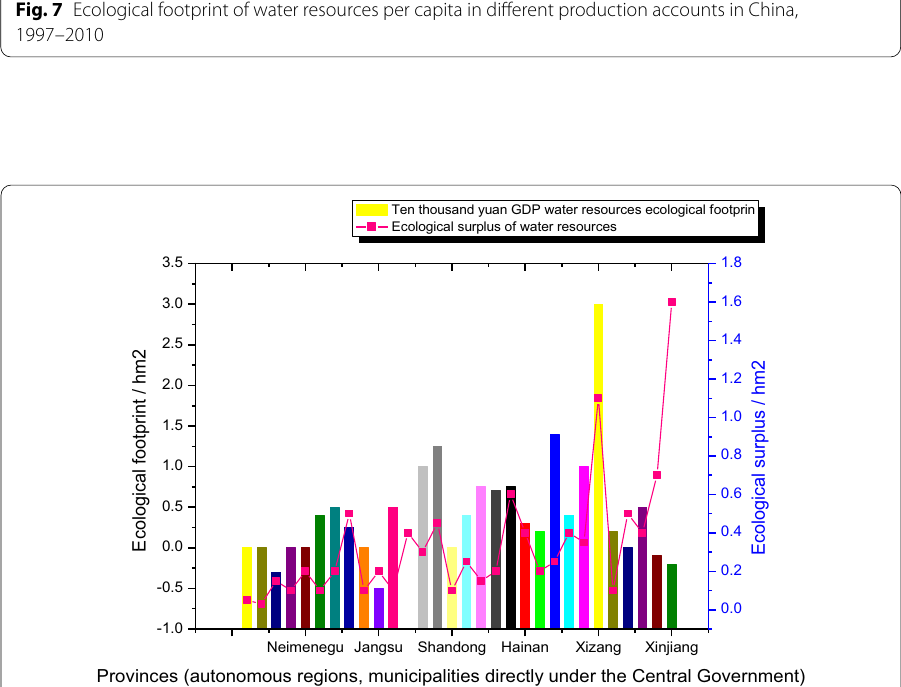
Fig. 8 National GDP water ecological footprint and ecological